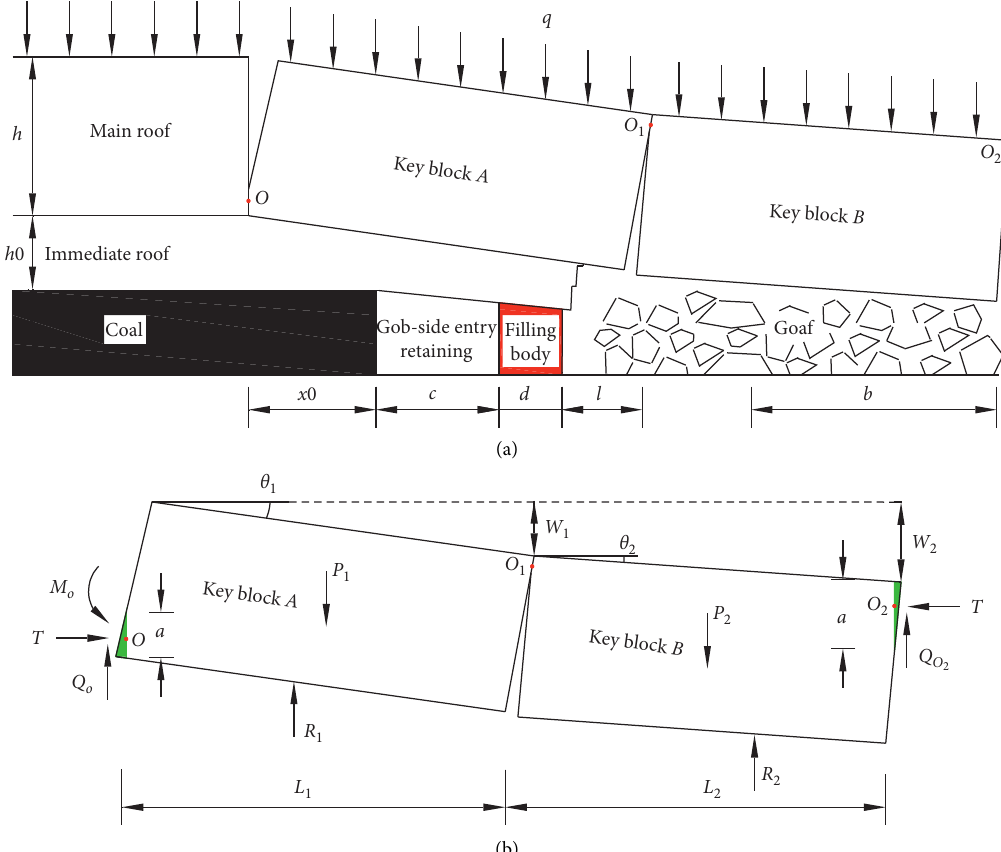
Figure 3: Mechanical model of short cantilever-articulated rock beam structure. (a) Diagrammatic sketch; (b) mechanical analysis